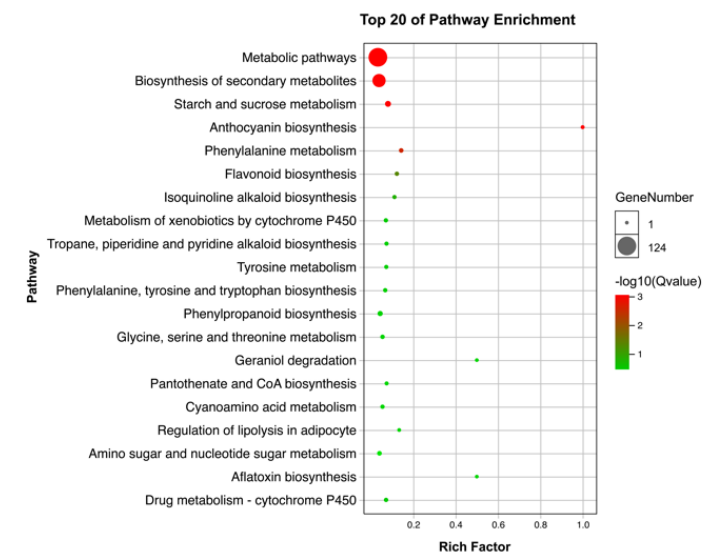
Figure 3. The 20 most KEGG pathway enrichment for DEGs. Rich Factor: DEGs numbers/total gene numbers enriched in the pathway. Table 3. Anthocyanin and Flavonoid Biosynthesis Pathway DEGs.